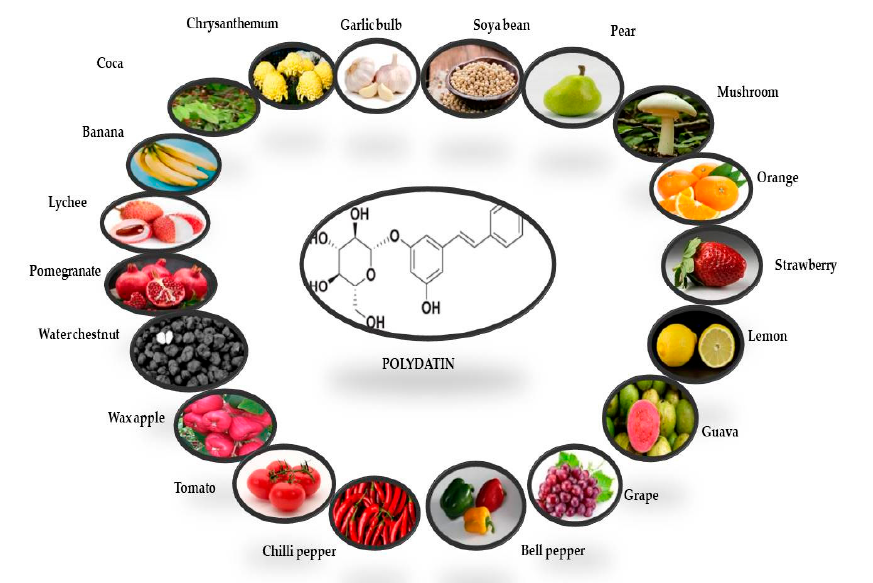
Figure 2. Potential dietary sources of polydatin derivative (transisomer). The quantities of PD in each fruit and vegetable have been derived from Peng et al.[35].